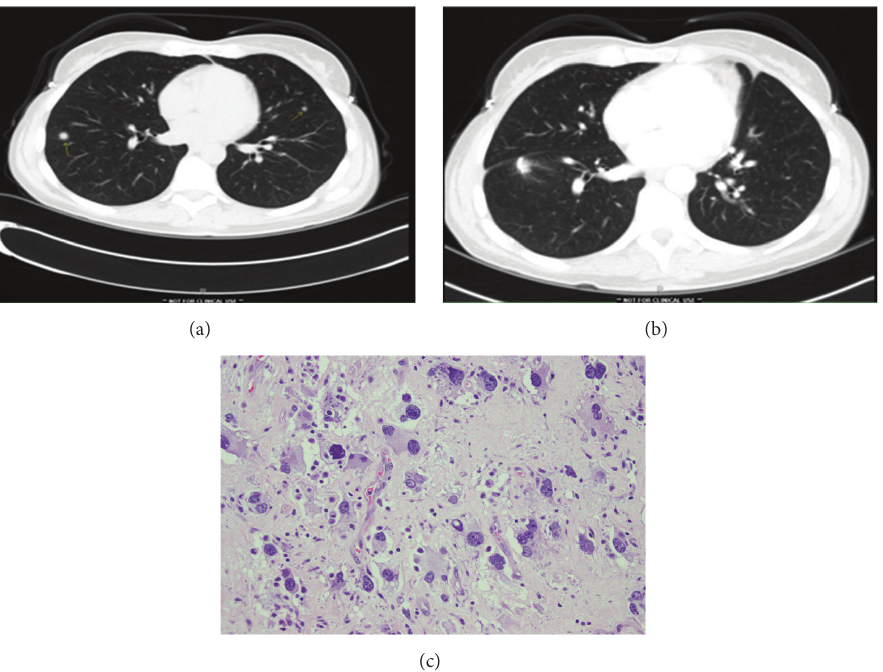
Figure 3: Pre- and postsurgery CAT scan of a 46-year-old lady with history of dedifferentiated liposarcoma patient who completed the DC vaccine + RT treatment, underwent surgical resection, and approximately 10 months later presented with (a and b) pre- and post-CT scans showing the presence of the lung nodules (two) and then postsurgical imaging study after its resection. (c) Pathological analysis showed tissue necrosis, hyalinization, and infiltration of lymphocytes and is currently free of systemic or local recurrence over 8